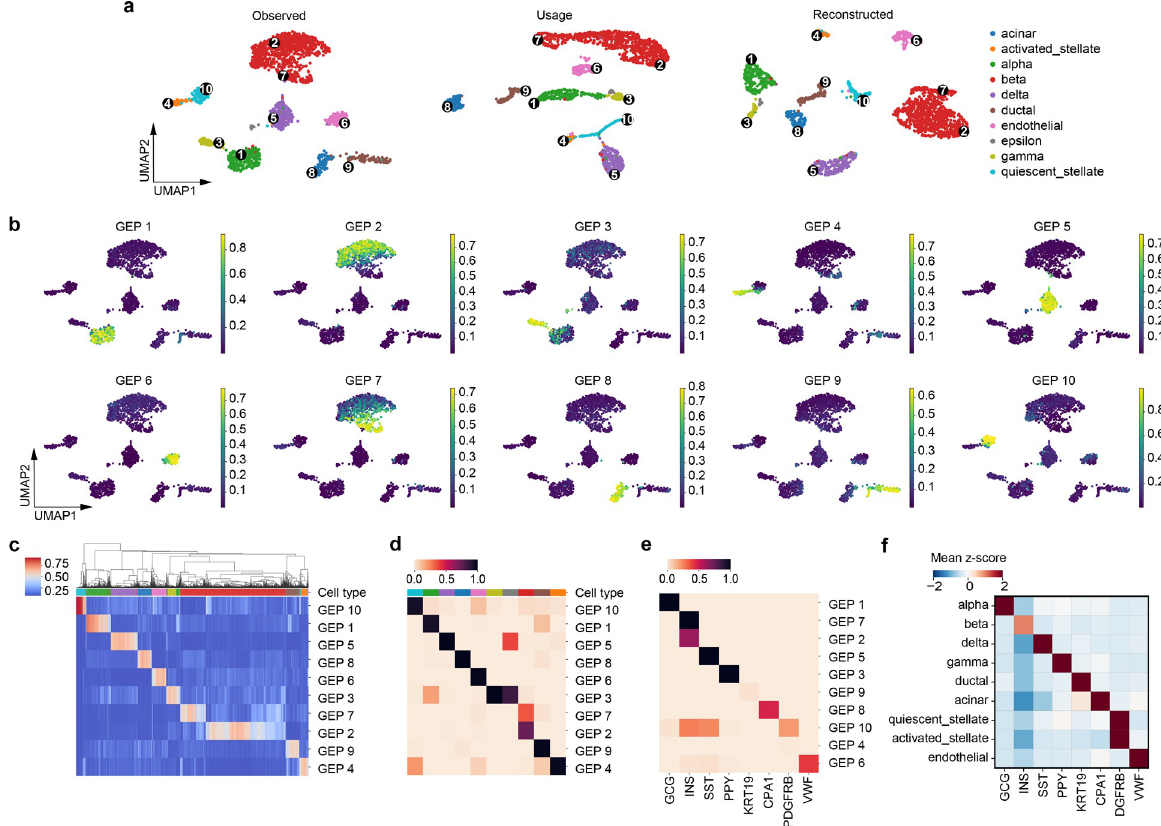
Fig 5. scAAnet identified archetypes with correspondence to known cell types in the pancreatic islet dataset. (a) The UMAP visualization using the top 35 PCs of the observed scRNA-seq data (left), using the inferred cell usage matrix from the encoder (middle), and using the reconstructed expression profile from the output layer of scAAnet (right). UMAPs are colored by 10 known cell clusters. The average Silhouette scores for the three UMAPs are 0.604, 0.398 and 0.613, respectively. Black dots are locations of cells that have the largest usage of the corresponding GEP (marked in Arabic numerals). (b) UMAPs from the observed data colored by inferred cell usage for each GEP. (c) Heatmap showing the usage of all GEPs (rows) in all cells (columns). Cells are ordered by hierarchical clustering. (d) Heatmap showing the percentage of cells with usage > 25% of each GEP (rows) in each cell type (columns). Colors in c and d are coded in the same way as those in a. (e) Normalized gene scores (Methods) of known markers (columns) in each GEP (rows). (f) Mean z-scores of known markers (columns) in each cell cluster